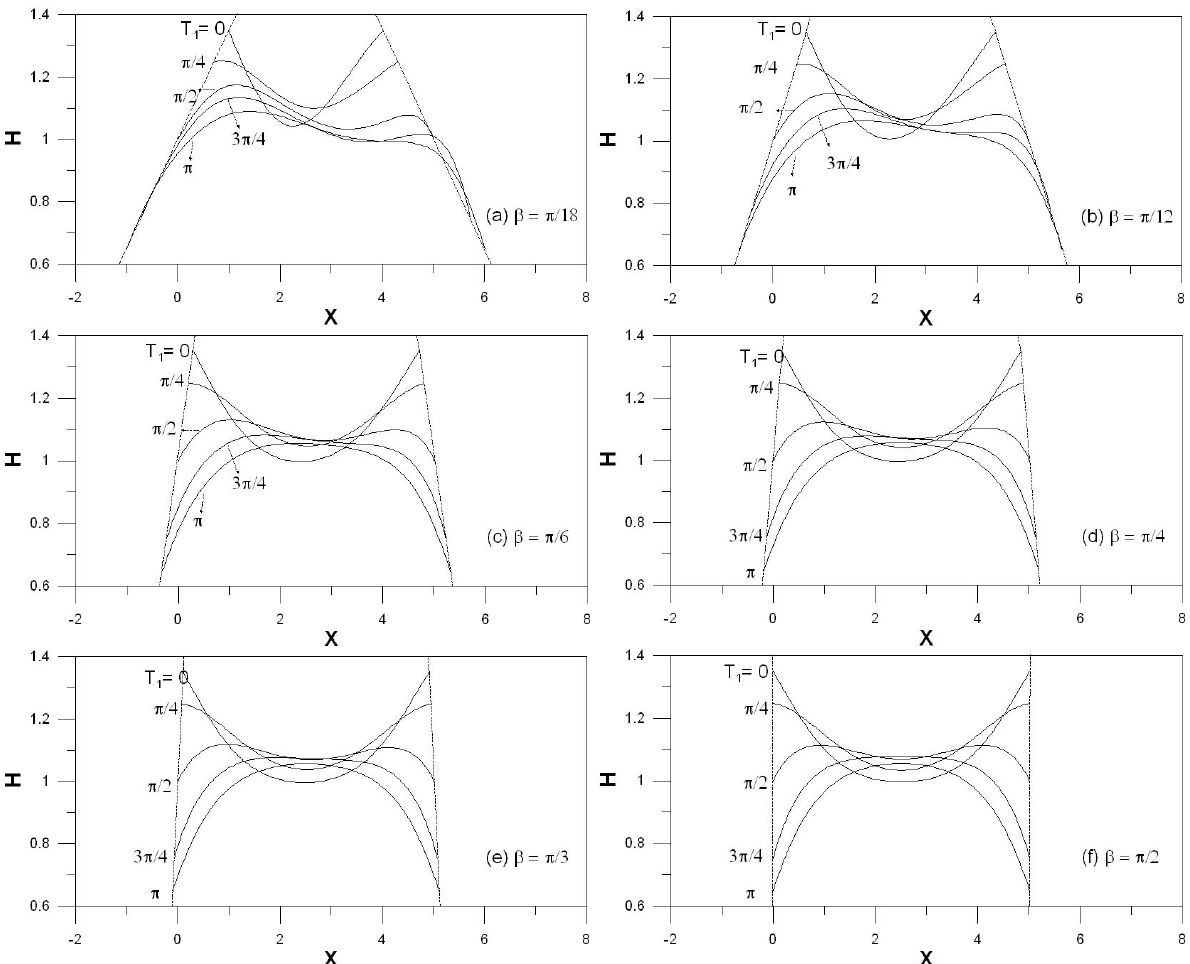
Fig. 4. Distribution of water table level ( H ) versus horizontal distance ( X ) for various beach slopes ( ε = 0 . 5, α = 0 .